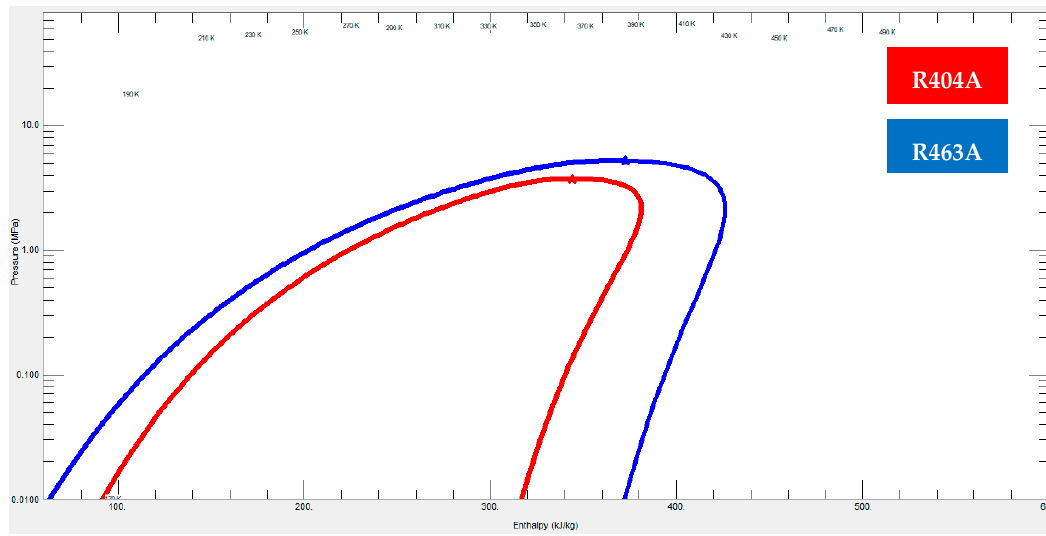
Figure 7. Properties of R463A obtained from REFPROP.